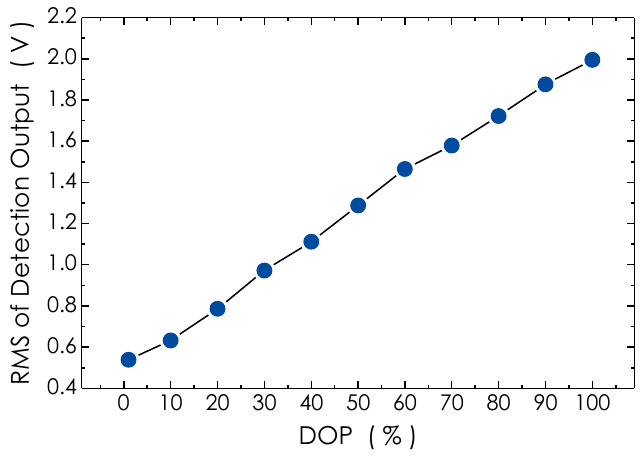
Figure 14. Measured result on the relation between sensor sensitivity and the DOP of the laser